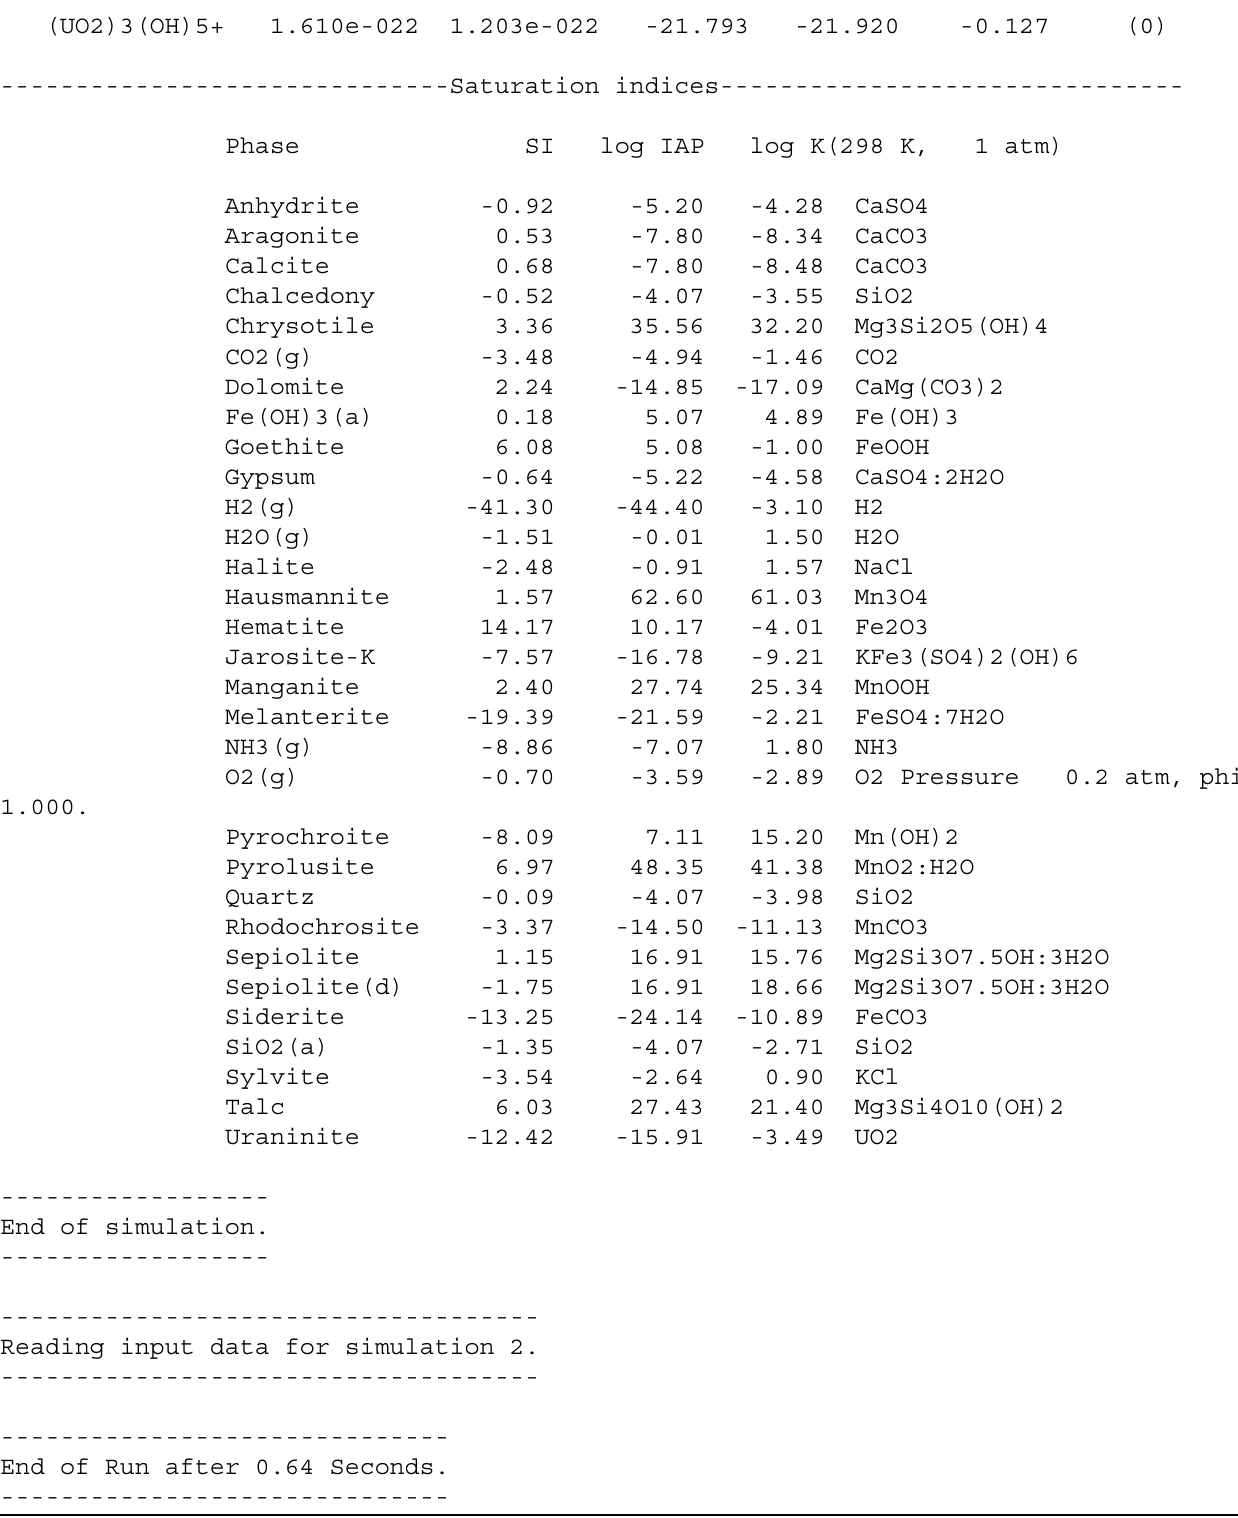
Table 11. Output for example